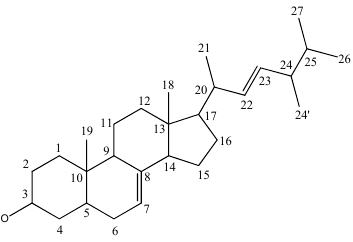
Figure 2. Stellasterol isolated from Ganoderma australe .